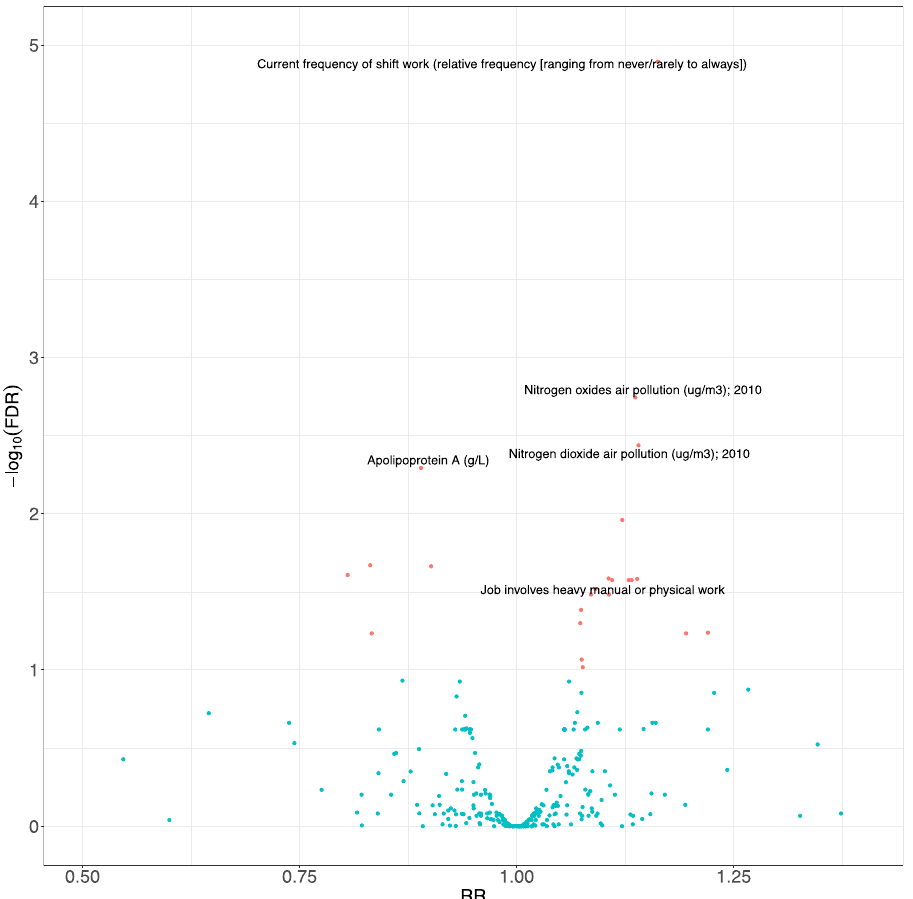
Fig. 2 Association size versus -log10(adjusted p -values) between 360 exposures and COVID-19 positivity for fi rst time point (tests until 07/17/ 2020). The risk ratios (RR) versus the negative log (base 10) of FDR-corrected p -values for 360 different exposures. The red color indicates FDR < 0.1 signi fi cant exposures and the blue color indicates FDR > 0.1 exposures. For the underlying dataset, n =